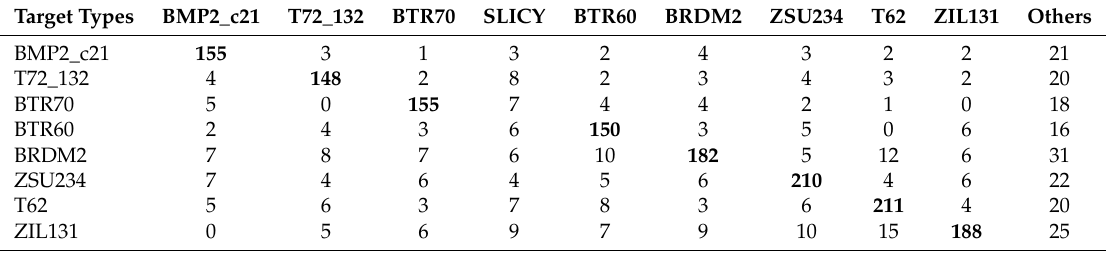
Table 3. Test results of the same data domain HRRP sequence in the MIBL-softmax